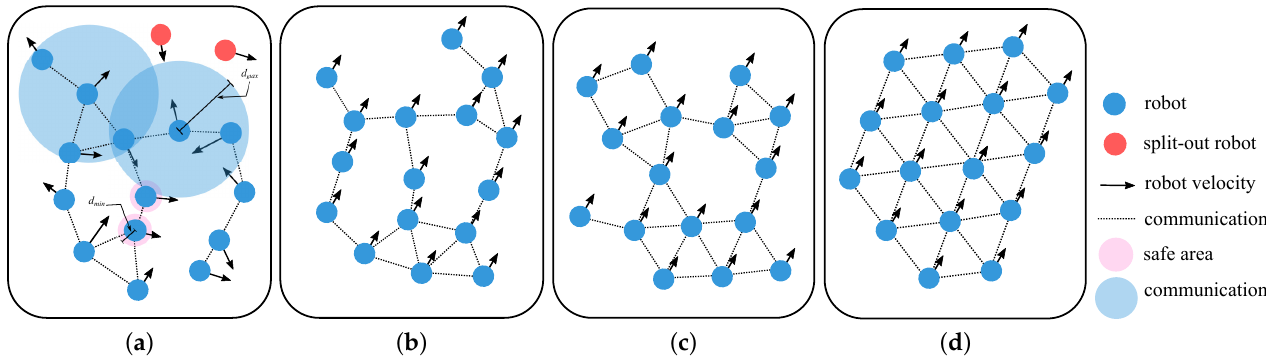
Figure 1. The flocking task. ( a ) Avoiding collisions and maintaining connectivity. ( b ) Achieving velocity consistency. ( c ) Achieving one-hop distance consistency. ( d ) Achieving graph importance